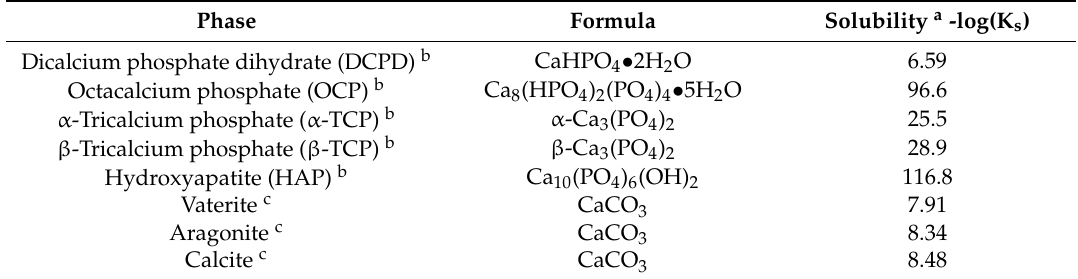
Table 1. Chemical formulae and solubility of common phosphate and carbonate minerals. Phase Formula Solubility a -log(K s ) Dicalcium phosphate dihydrate (DCPD) b